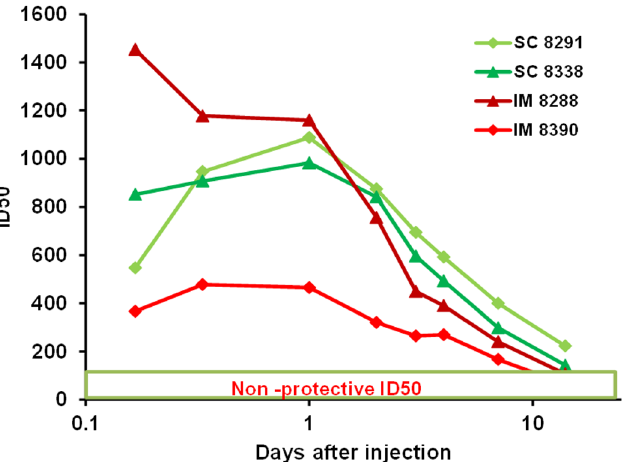
Fig 1. Circulatory clearance profiles of 5mg/kg of plant-derived PGT121 in African Green monkeys following SC and IM injections. Neutralizing ID50s were assessed at different times after injection using a pseudovirus-based TZM-bl assay against the Tier 2 SHIV-SF162P3.